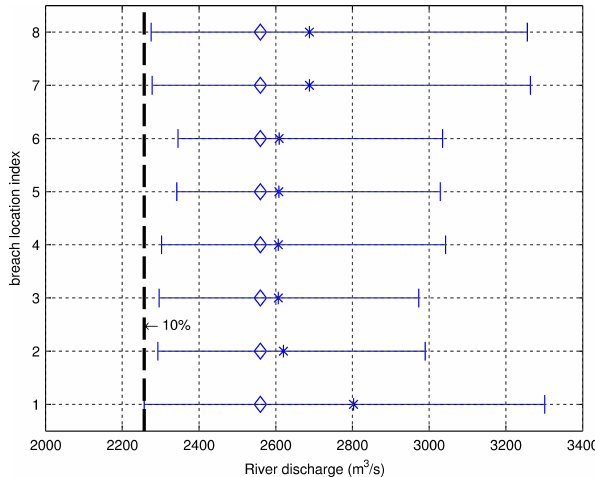
Figure 6. Determination of the resistance threshold for the refer- ence situation, based on the fragility curves of eight breach loca- tions (0.1, 0.5 and 0.9 values). Vertical dashed line indicates the system resistance threshold as the lowest 10% value of all loca- tions. The diamond indicates the resistance threshold when it would be assumed equal to the design